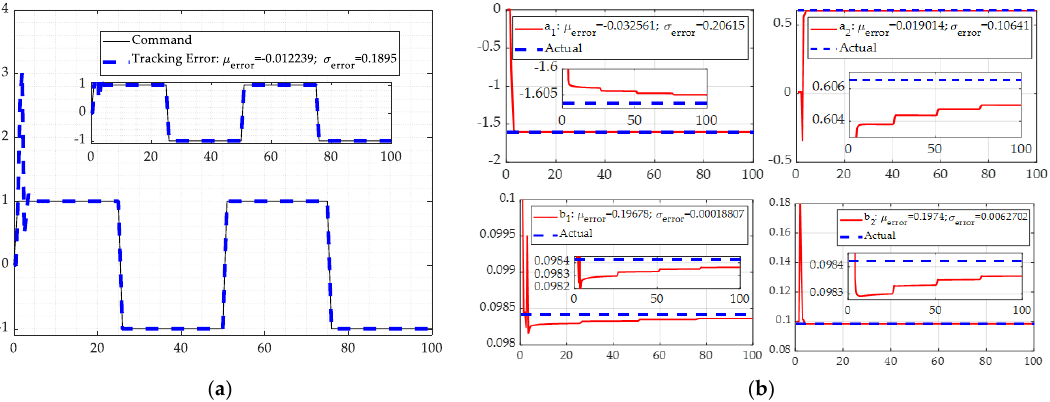
Figure 8. Deterministic artificial intelligence (where timesteps appear on the abscissa). ( a ) Command trajectory tracking by deterministic artificial intelligence with noteworthy comparable initial overshoot, but seemingly eliminating overshoot and settling at each switch of the square wave. ( b ) Coefficient estimation illustrating rapid convergence towards the correct coefficient value with continued convergence at very small scale with time passage.